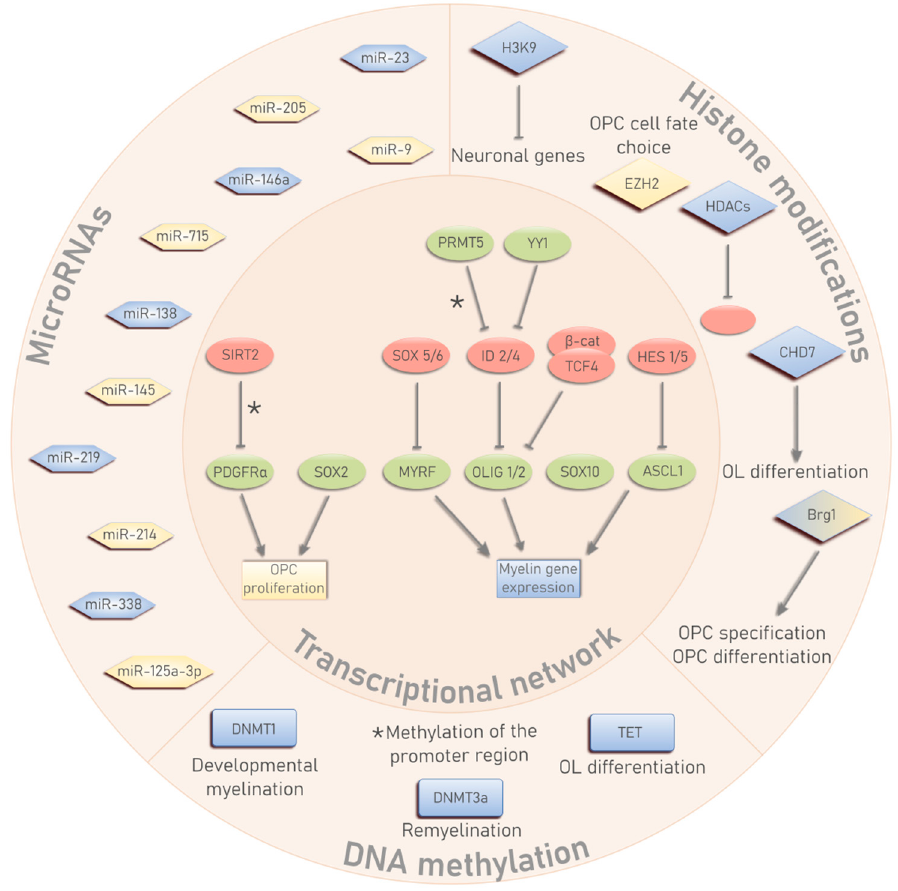
Figure 1. An overview of the transcriptional and epigenetic regulation of oligodendrocyte precursor cell (OPC) proliferation and oligodendrocyte (OL) development. Transcription factors that exert a positive or negative e ff ect on these processes are depicted in green and red, respectively. Pro-proliferative factors are visualized in yellow, whereas pro-di ff erentiation factors are blue. * Methylation of the promoter region.